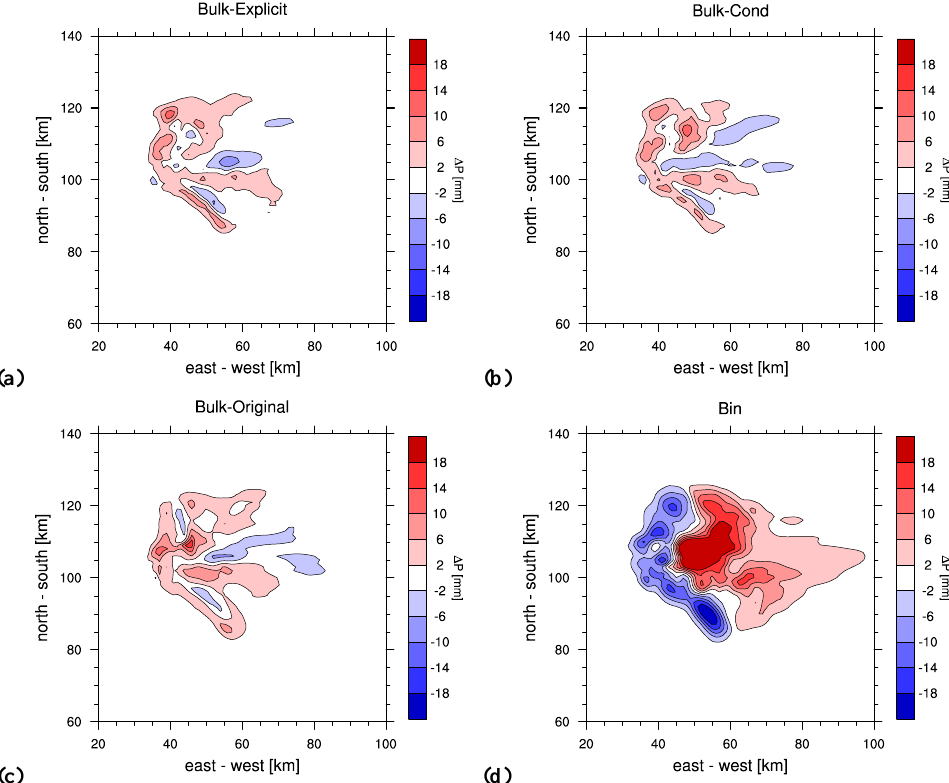
Fig. 3. Contour plots of the change in cumulative precipitation ( 1P , “Polluted” minus “Clean”) at 90min for all model configurations and baseline initial conditions. Precipitation is given in mm. Note that only the portion of the domain in which precipitation has accumulated is shown. Here, red implies an increase in precipitation with increased aerosol loading and blue a